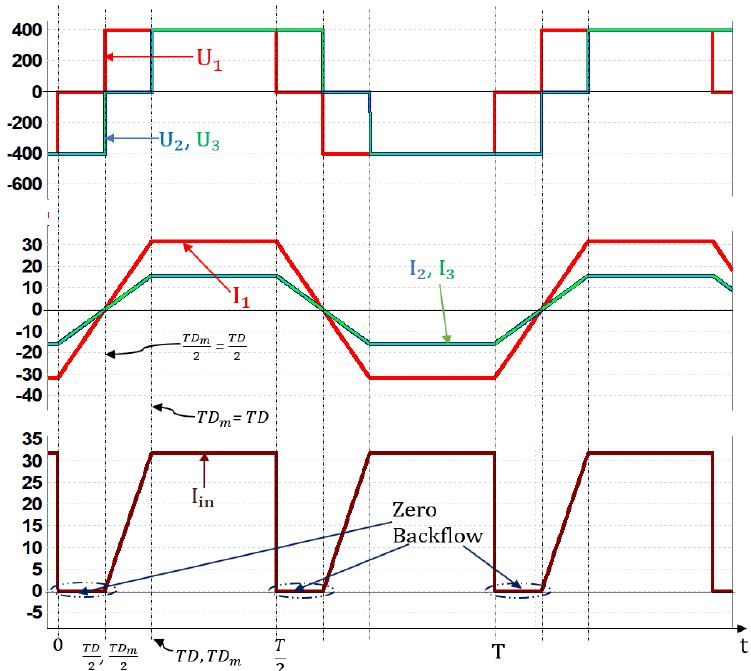
control scheme, is greater than the outer phase shift angle, D m (as illustrated in Figure 6). For this simulation, D = 45° while the outer phase shift angle remained at D m = 38.7° . Furthermore, it is observed that when the zero-level of the transformer voltages overlap (due to the inner phase-shift angle being greater than the outer phase-shift angle), the transformer currents are clamped to zero (this is seen on the middle curve of Figure 6, i.e., TD m ~ TD ), resulting in zero power being transferred during this period. When there is 2 2 zero power transfer, there is consequently zero backflow power.